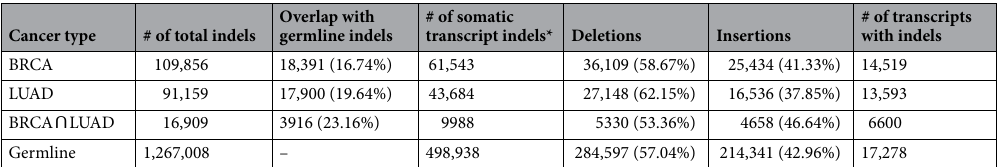
Table 1. Somatic transcript indels in BRCA and LUAD. *The numbers of somatic transcript indels in BRCA and LUAD are indels on transcripts after removing the ones that overlap with germline indels.